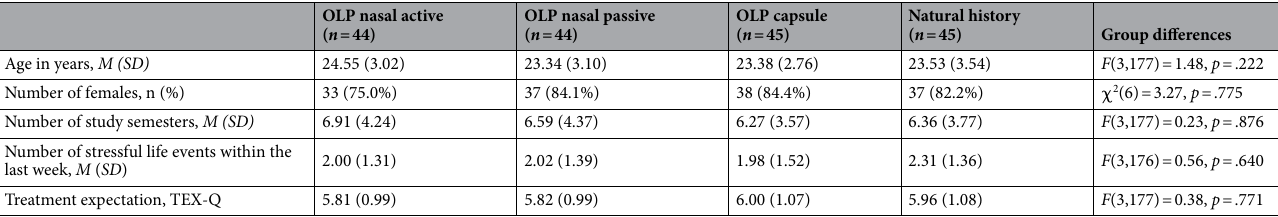
Table 1. Sample characteristics and group differences at baseline. M mean; SD standard deviation ; n number of participants; TEX-Q Treatment Expectation Questionnaire, ranging from 0 to